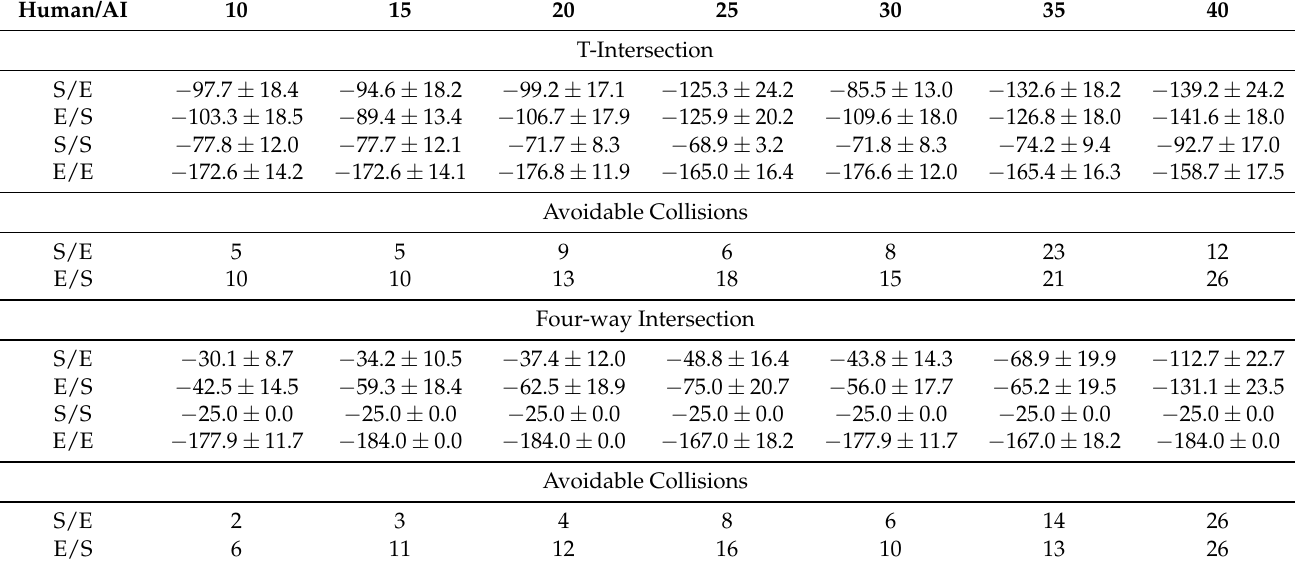
Table 20. Mean rewards and avoidable collision counts (by human–AI configuration) for a random manager with given delegation interval lengths in the human: weather, AI: weather and color